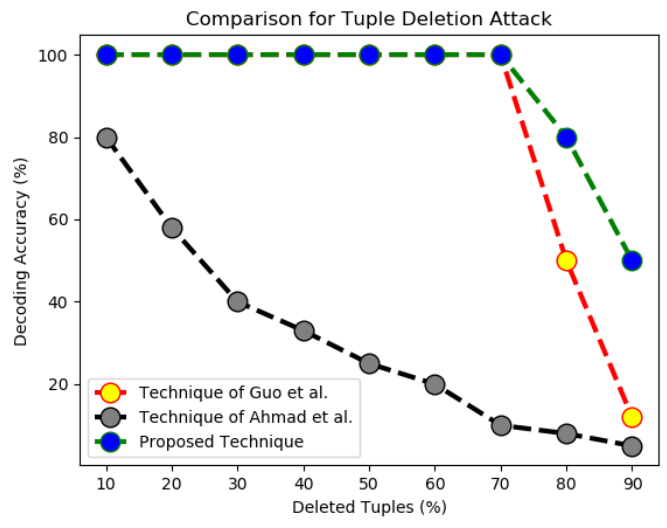
Figure 6. Comparison of techniques for tuple deletion (or subset selection